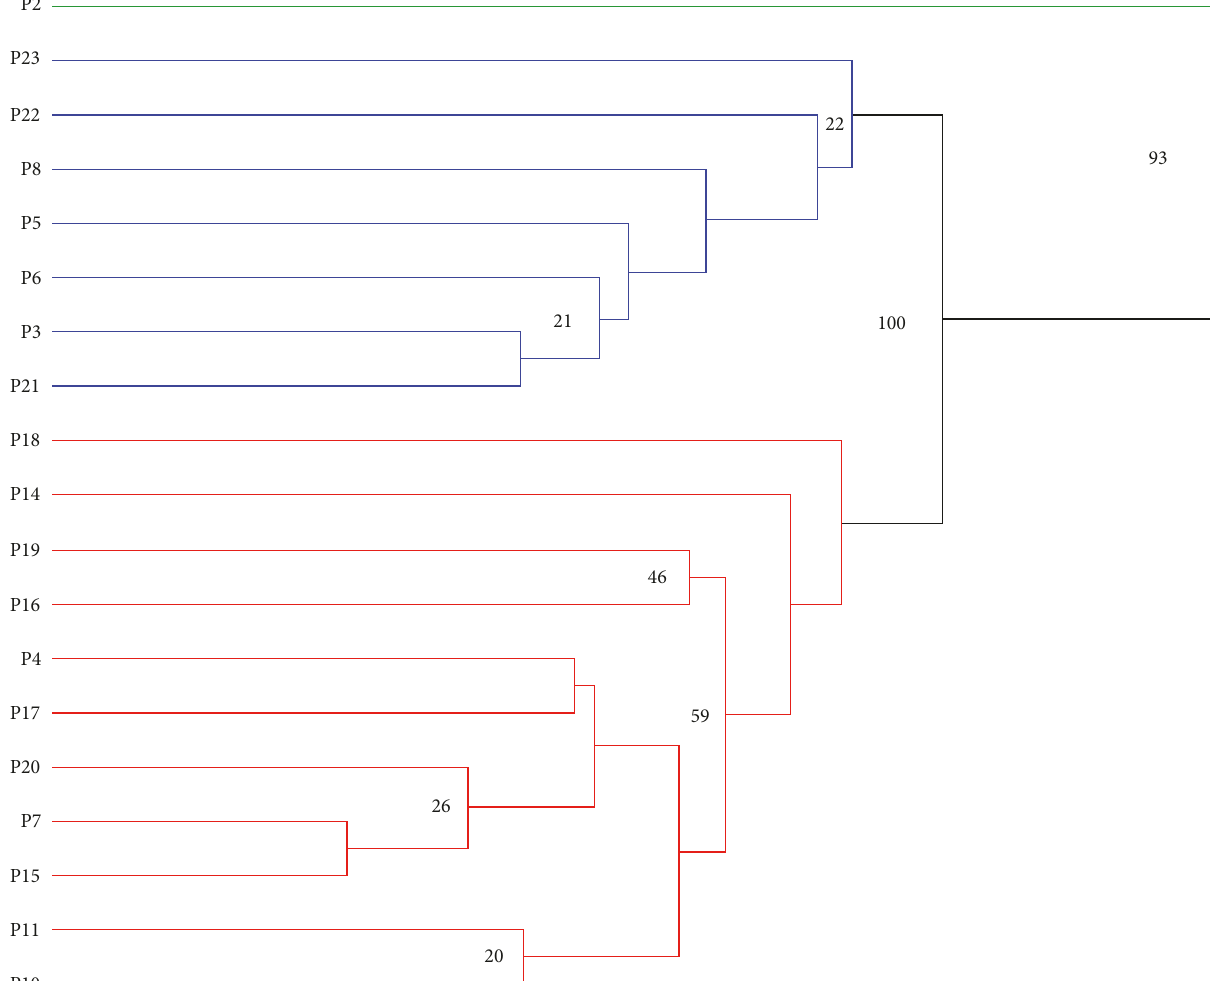
Figure 7: Phenotypic dendrogram for 19 individuals belonging to NP-2024 accession at EETP C. canephora collection. The phenotypic data were collected between 2010 and 2012 for vigor traits (productivity, stem diameter, plant height, number of branches, number of nodes, and internode length). Branch support is expressed in percent of presence after 10000 bootstraps (values above 0.2 are